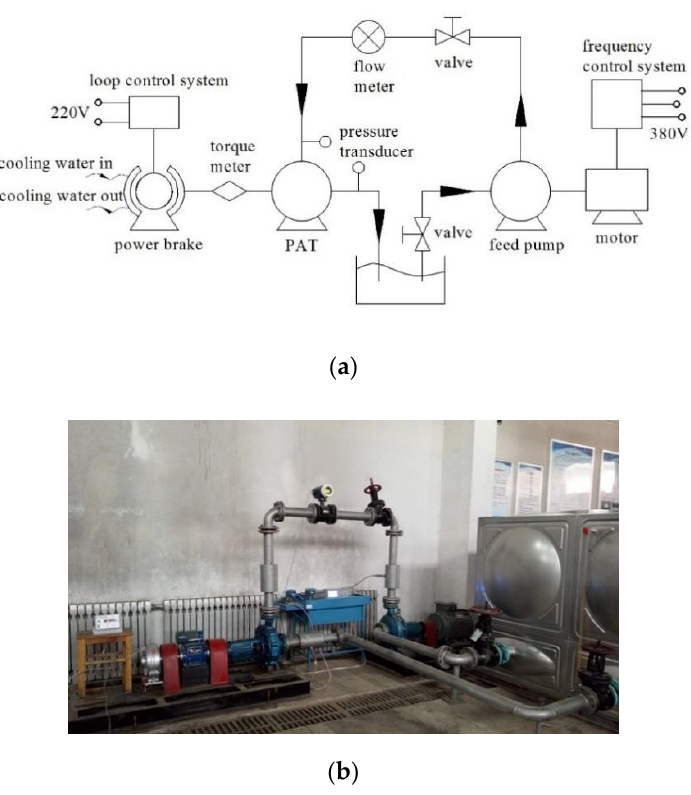
Figure 7. Experimental equipment of PAT. ( a ) Schematic diagram of experiment; ( b ) test rig.